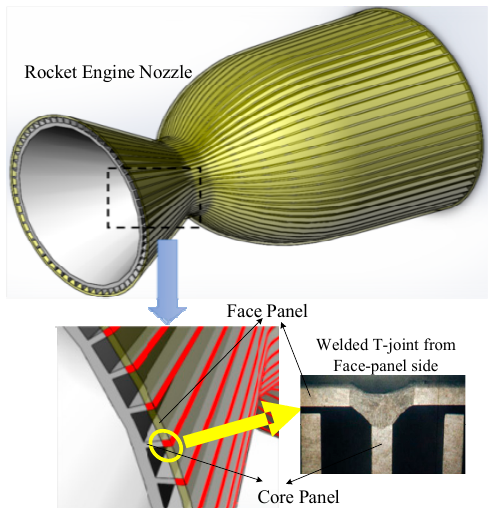
Figure 1. Welded T-joint from the face panel side in the sandwich structure for a rocket engine